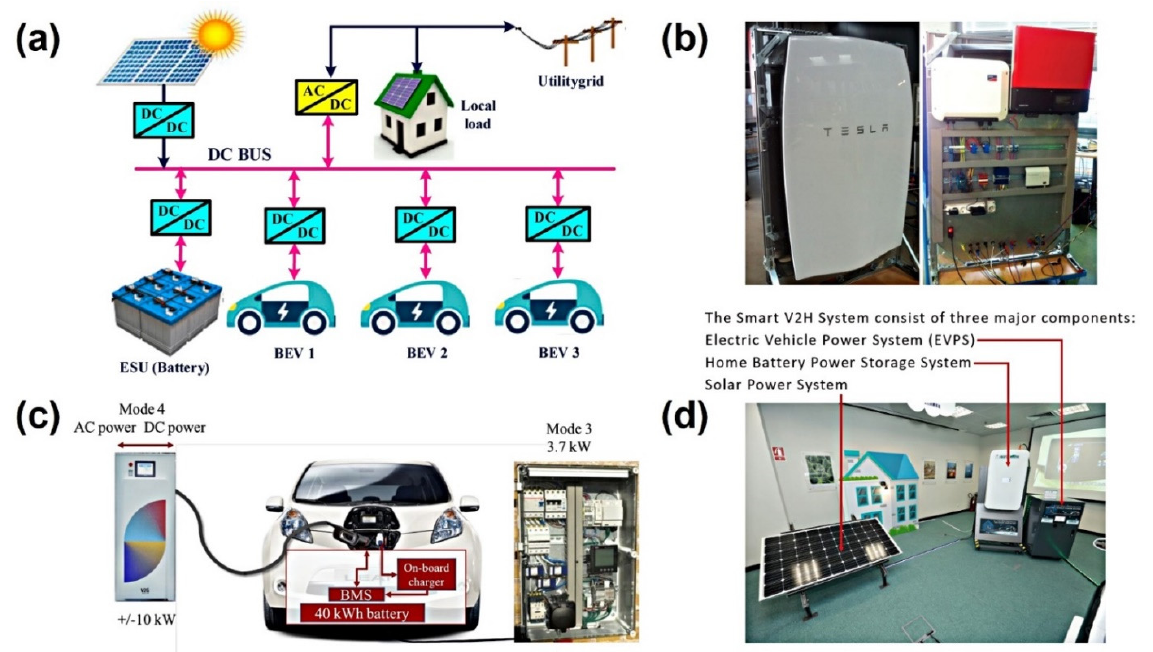
Figure 6. Representative V2G and V2H systems in different countries: ( a ) “Amsterdam Vehicle 2 Grid” system [69]; ( b ) Tesla’s Powerwall 2 [70]; ( c ) V2G-ready vehicle launched by Nissan [71]; ( d ) Smart V2H System developed by APAS and HKPC.